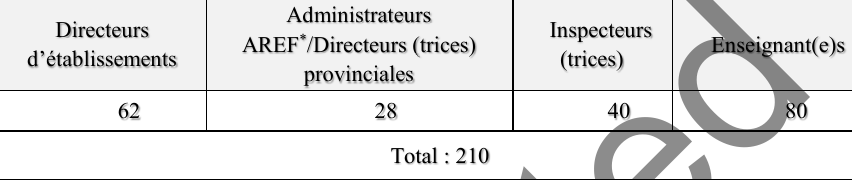
Tableau 1 : les acteurs ressources, lors de l’étape exploratoire de la recherche.